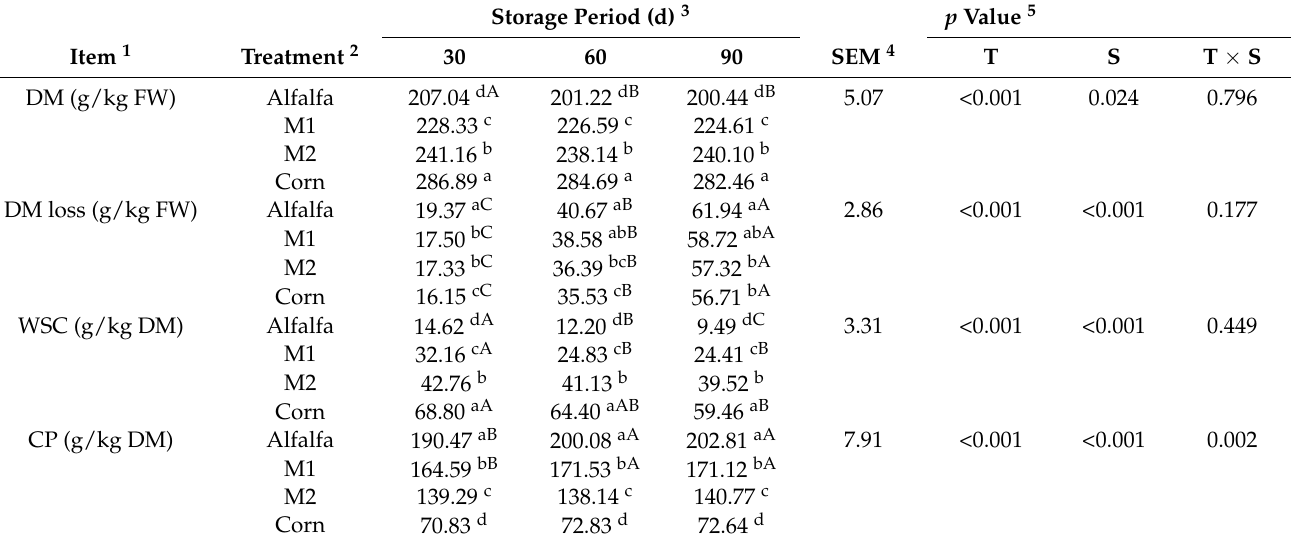
Table 2. Dynamics of chemical composition of silage during storage ( n =